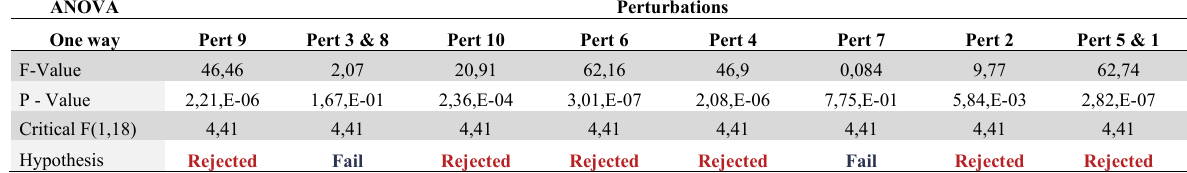
Manufacturing execution monitoring degradation and choosing best AGA control strategy ANOVA